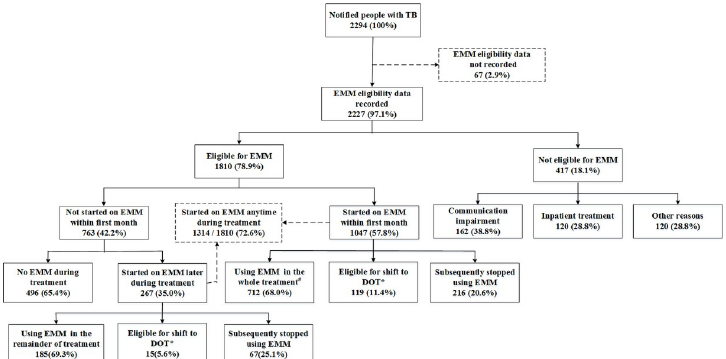
Fig 2. The flow chart depicting EMM eligibility, uptake and adherence among notified people with TB in the 30 selected counties of China between July and December, 2018. TB–tuberculosis; EMM–electronic medical monitor; DOT- directly observed treatment # Using EMM more than 6 month for new patients and 8 month for previously treated patients, besides there was no evidence of non-adherence � Continued instance of missing 20–49% of doses or a single instance of missing � 50% of doses in a